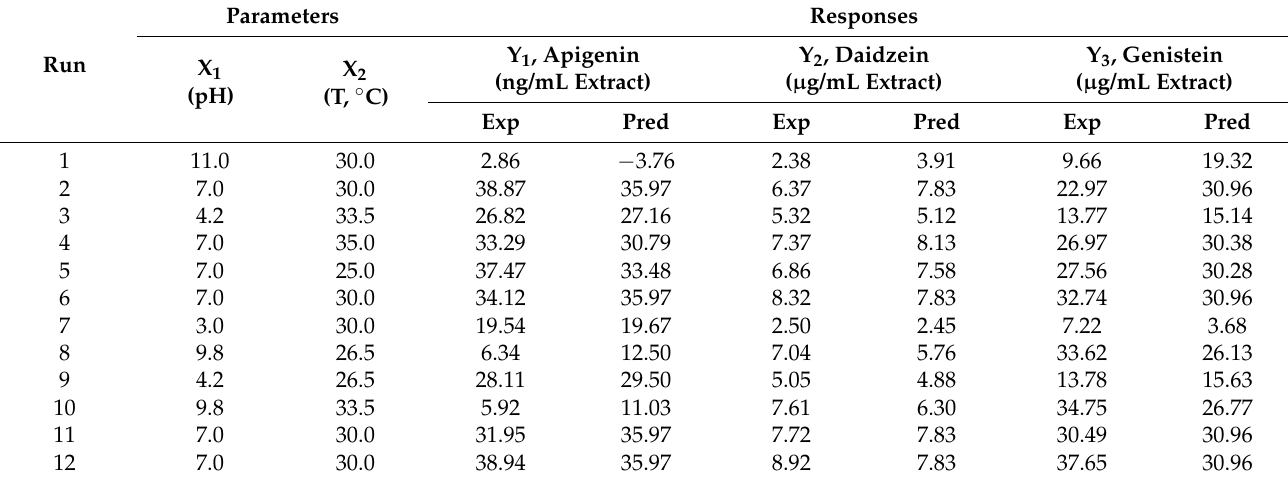
Table 1. Experimental and predicted concentrations of apigenin, daidzein and genistein of the germinated soy-supplemented celery extract obtained by CCD. Experimental values are expressed as the average of triplicate determination from different experiments, while predicted values were calculated based on CCD